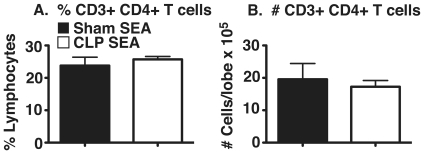
Percentage and total number of CD3+ CD4+ T cells in lungs of SEA-challenged mice.Lobes from sham and CLP RAG SEA-challenged mice were processed into a single-cell suspension and analyzed via flow cytometry for the presence of CD3+ CD4+ T cells. (A) Percentages of CD3+ CD4+ T cells were obtained by gating on total lymphocytes based on forward/side scatter profile. (B) Total numbers of CD3+ CD4+ T cells were obtained by multiplying the percentages obtained via flow cytometry via the total viable cell count (hemacytometer & vital dye exclusion). Data presented is representative of two separate experiments, n = 5 per group. (*) = p<0.05 vs. sham RAG.